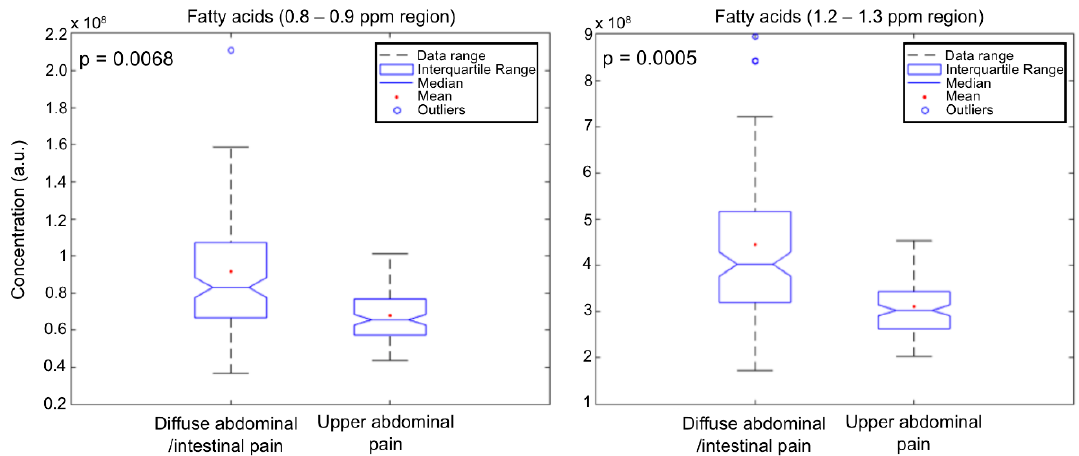
Figure 3. Boxplots and calculated probability values ( p ) from Kruskal–Wallis non-parametric analysis of variance test of the most weighted variables (metabolites’ NMR signals) for the two group of diseases classification. Boxplots depict the concentration (in arbitrary units, a.u.) of some of the weighted metabolites for the groups classification. The analysis was performed after integration of the NMR signals of the weighted metabolites from the serum CPMG spectra.